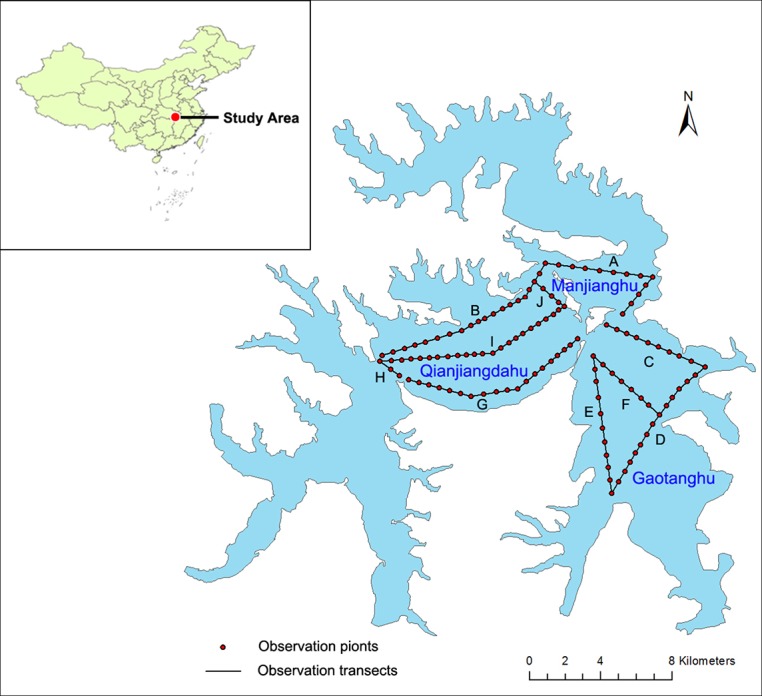
Map of Liangzi lake showing sampling sites observation points. Ten transects: A. B. C. D. E. F. G. H. I. J.